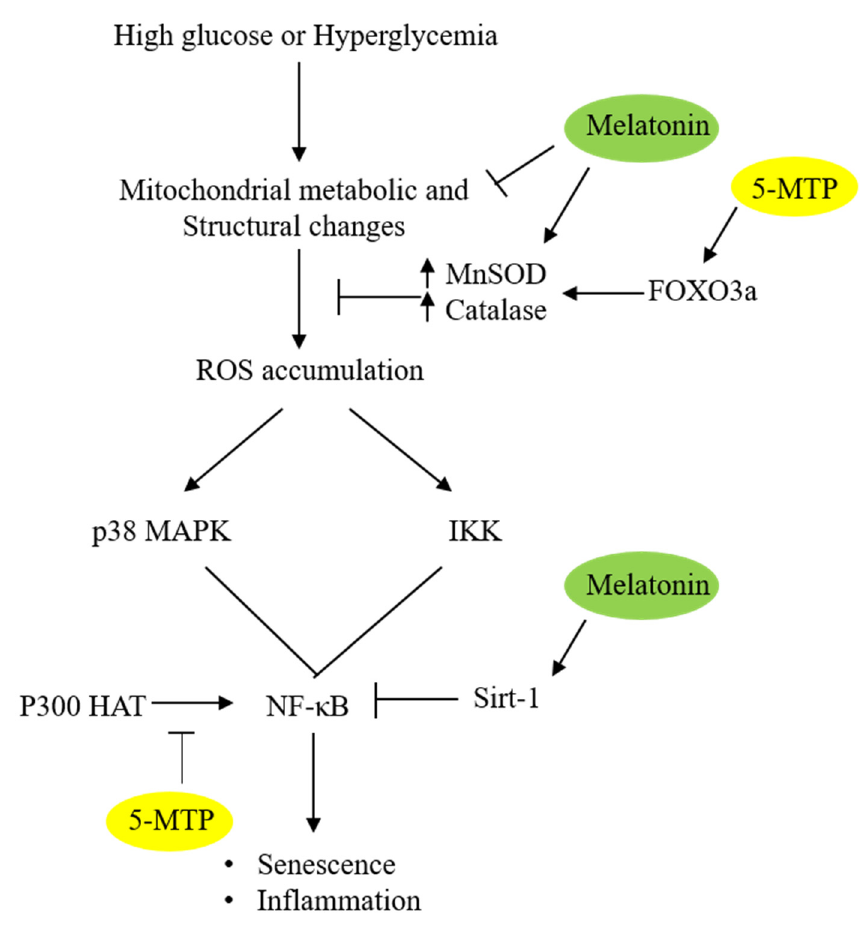
Figure 3. Schematic illustration of the anti-senescent actions of 5-MTP and melatonin. 5-MTP upregulates MnSOD and catalase activities via FOXO3a, thereby reducing ROS accumulation. Melatonin reduces ROS by upregulating MnSOD and catalase possibly via maintaining mitochondrial integrity. 5-MTP inhibits p300 HAT thereby reducing NF- κ B activity while melatonin upregulates Sirt 1 which de-acetylates p65 and suppresses NF- κ B activity.